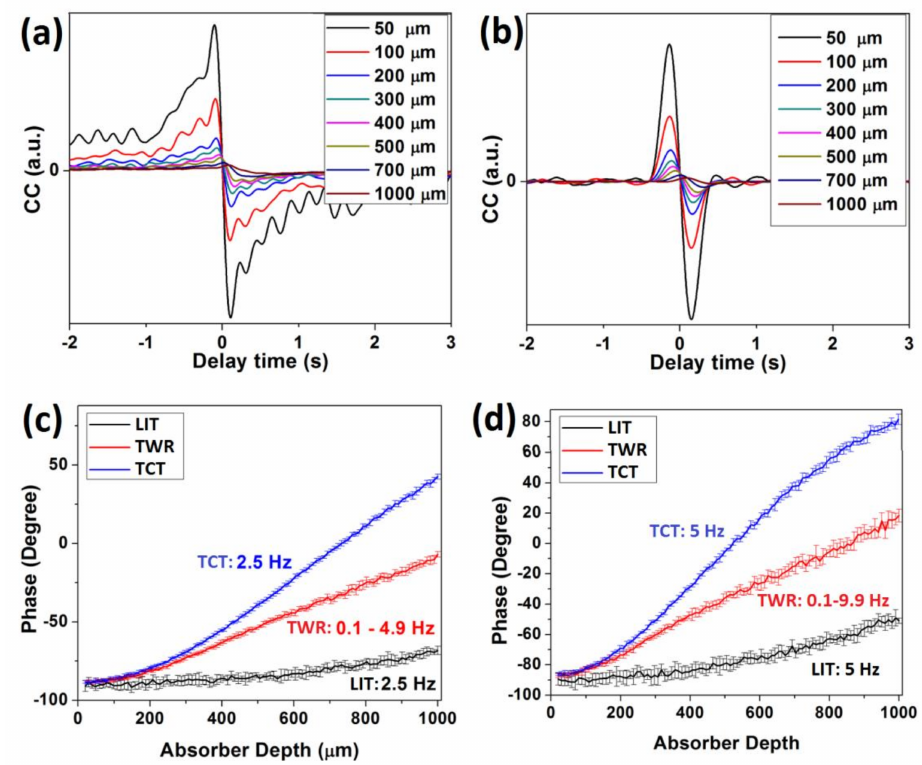
Figure 10. Simulated ( a ) TWR (0.1 Hz–4.9 Hz, 6.4 s) and ( b ) TCT (2.5 Hz, 16-bit coding) responses of turbid sample containing absorbers at several depths. Comparison of simulated phase responses using LIT, TWR, and TCT for absorbers in turbid medium. Turbid medium properties: µ a = 100 [m − 1 ], µ s = 6000 [m − 1 ], g = 0.96, r = 0.65, k = 0.9 [Wm − 1 k − 1 ], α = 5 × 10 − 7 [m 2 s − 1